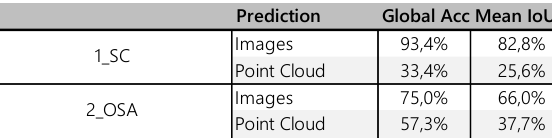
Table 8: Comparison between the neural network-based image segmentation results and the corresponding results on the 3D point